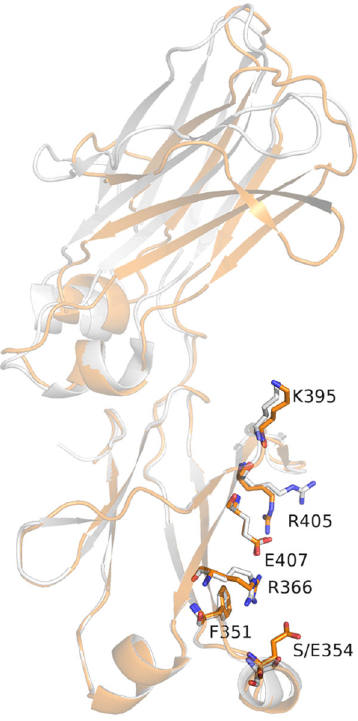
Fig. 3 Crystal structure of a new monomeric Fc, MFc3. MFc3 (Fig. 1a) in the aglycosylated form (N297D) was crystallized in the C222 1 space group with cell parameters a = 102.97 Å, b = 110.93 Å, c = 87.18 Å, Matthews parameter V M = 2.49 Å 3 /Da with two polypeptides in the asymmetric part of the unit cell, and solvent content of 50.62%. The diffraction limit of the crystal was 2.3 Å. The structure was solved by a molecular replacement method implemented in MolRep within the CCP4 suite of programs, using a model of C4 n (PDB ID: 5HVW) as a starting model 33,35 . Re fi nement was performed using Refmac5 while manual building/rebuilding was performed using “ O. ” 39,42 Data collection and fi nal re fi nement statistics are shown in Table 1. Superposition of MFc3 (orange) with a previously resolved structure of MFc2 (or C4 n ) (light purple) shows that both maintained a similar monomeric Fc structure, and the S354E mutation did not cause any notable change in the Fc domain structures. As designed, the glutamate side-chain due to the S354E mutation protruded into any possible dimer interaction observed in T1 (Fig.